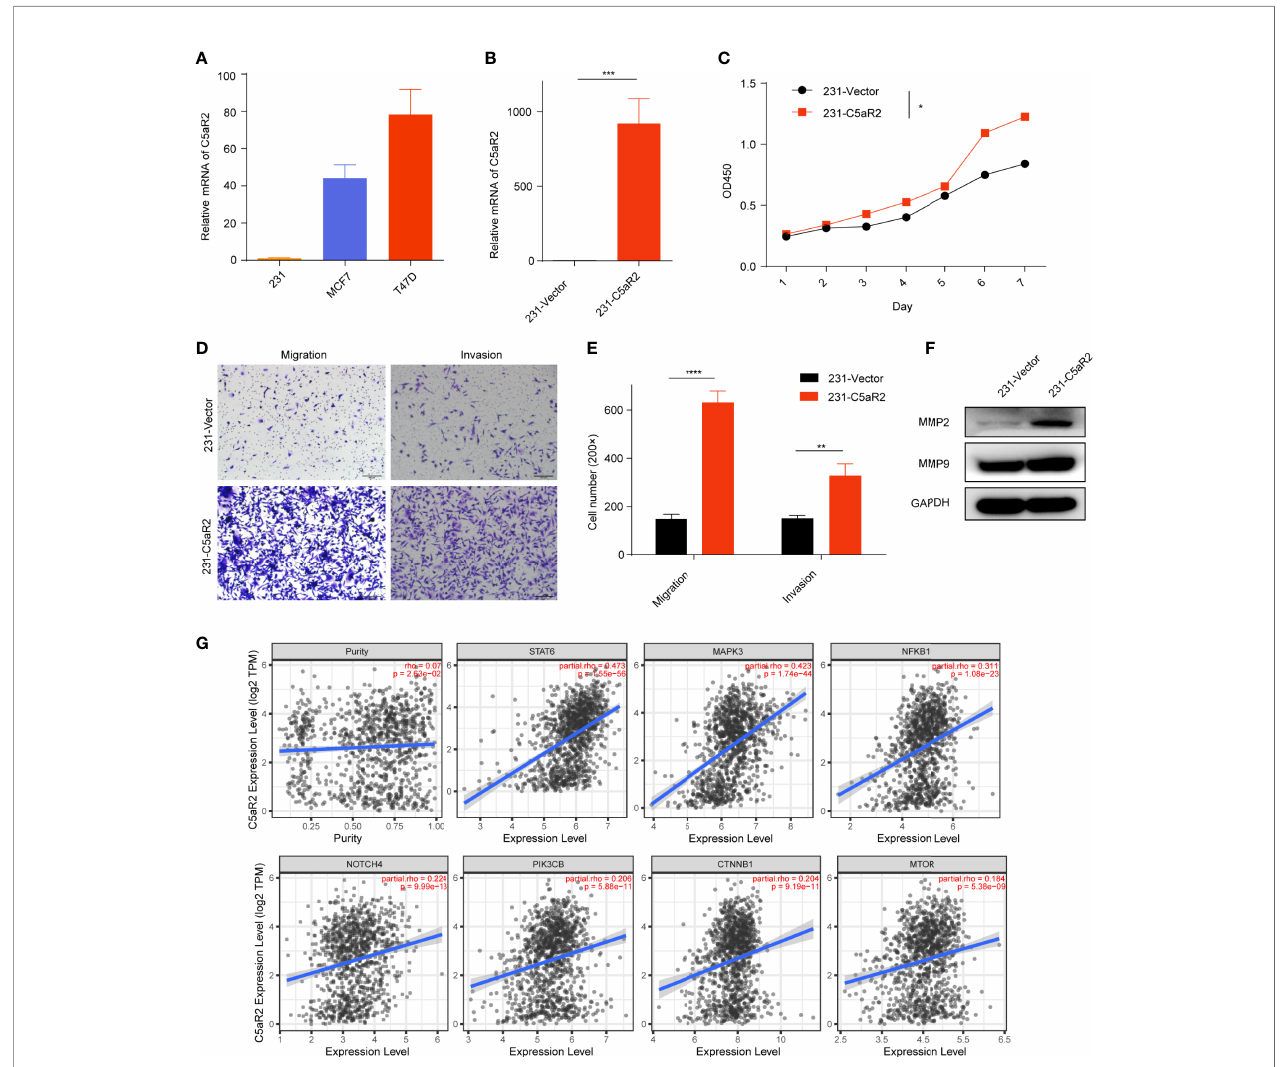
FIGURE 6 | Overexpression of C5AR2 facilitated the migration, invasion, and proliferation in breast cancer cells. (A) C5AR2 expression levels were measured in various breast cancer cell lines through qRT-PCR. (B) MDA-MB-231 cells were transfected with C5AR2 overexpressed plasmid, and the level of C5AR2 was measured through qRT-PCR. (C) The proliferation of MDA-MB-231 cells was measured through CCK8 assay. (D, E) The migration and invasion of MDA-MB-231 cells were measured through transwell assay. (F) MMP2 and MMP9 expression levels were measured through Western Blot in control and C5AR2 overexpressed MDA-MB-231 cells. (G) Correlation between C5AR2 and certain classic genes in key signaling pathways in breast cancer through TIMER database. *P < 0.05, **P < 0.01, ***P < 0.001, and ****P <